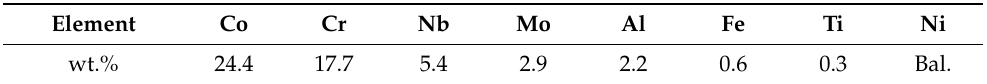
Table 1. Chemical composition of the investigated VDM ® Alloy 780 samples as measured by spark spectrometry.